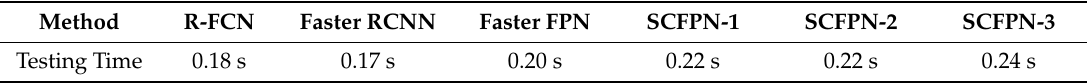
Table 5. The average testing time for the different methods.